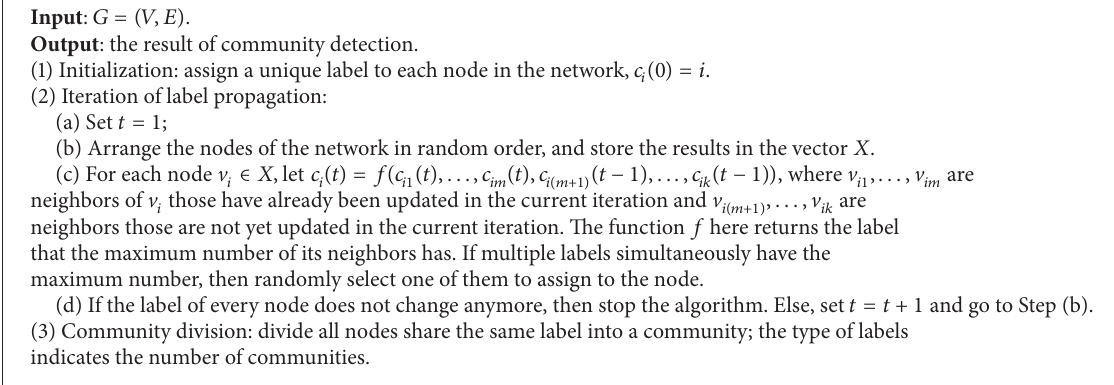
Algorithm 1: Label propagation algorithm for community detection in networks (LPA).